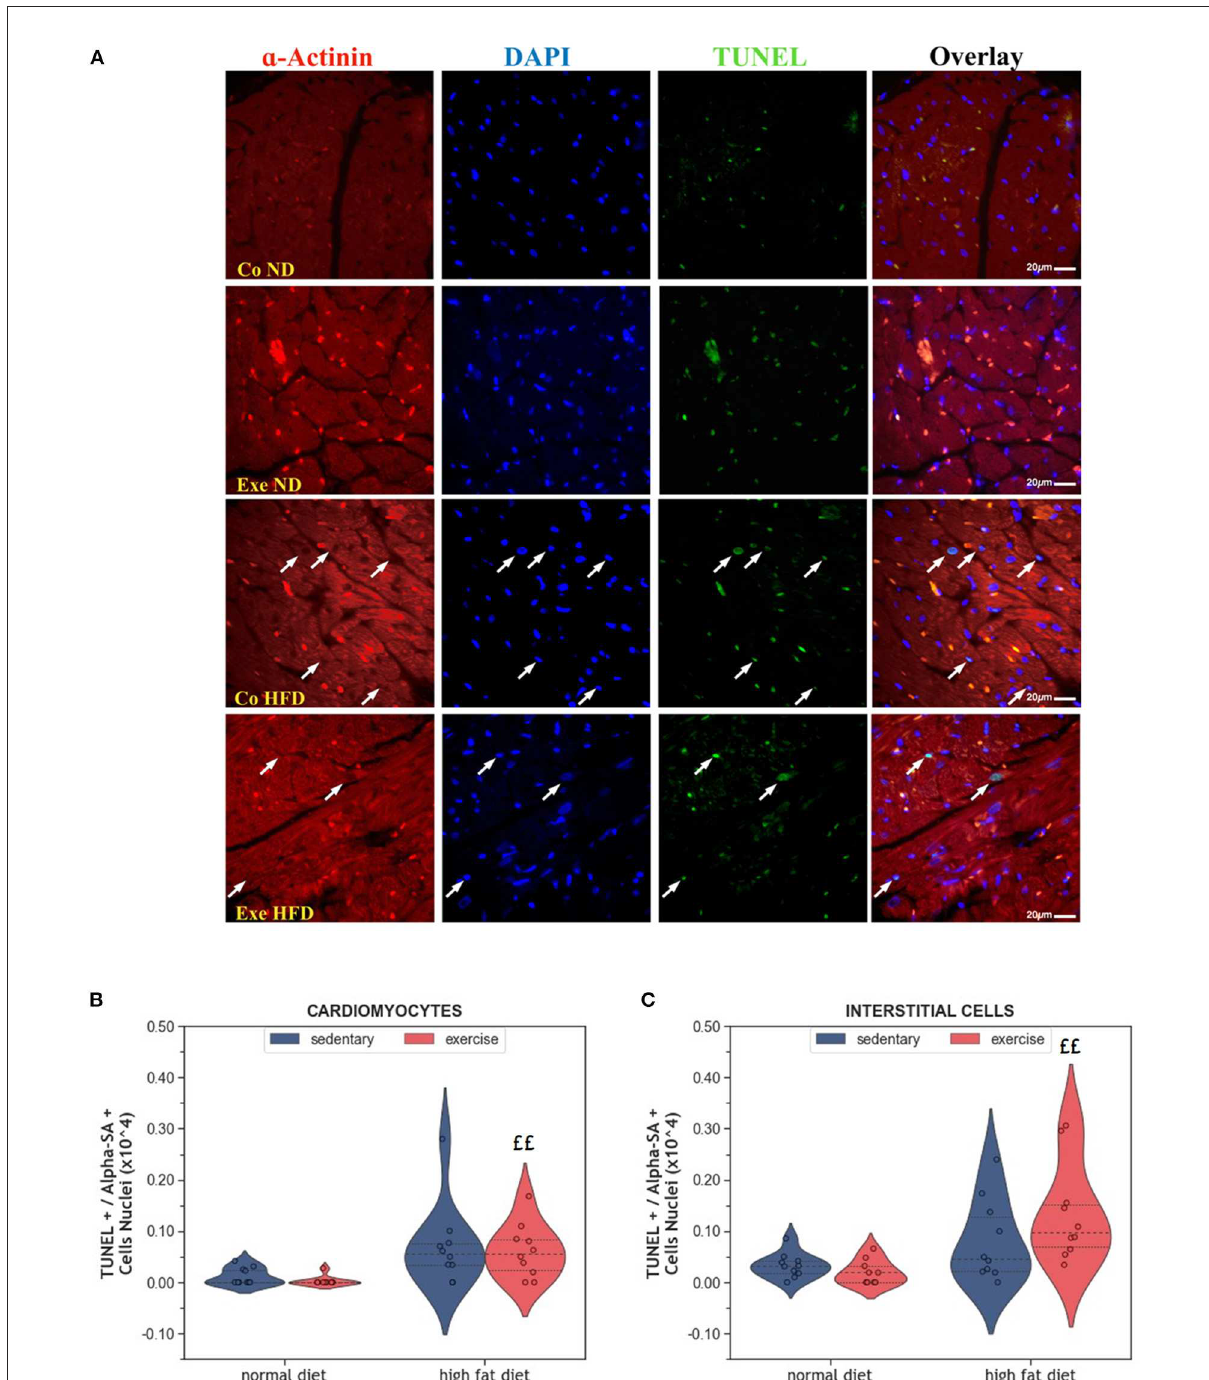
FIGURE3 (A) Representative histological images of left ventricular sections showing an increased number of apoptotic cardiomyocytes in HFD groups. The sections have been stained with a commercial kit for terminal deoxynucleotidyl transferase dUTP nick end labeling (TUNEL) assay. Arrows point to apoptotic nuclei. (B) Violin plot showing the left ventricular fraction of Sarcomeric alpha-actinin positive cardiomyocytes that are also TUNEL positive. (C) Violin plot showing the left ventricular fraction of Sarcomeric alpha-actinin negative TUNEL positive interstitial cells. From each experimental group 10 animals were selected for histomorphometry analysis. Statistical differences between groups were calculated with the Kruskal-Wallis test adjusted by the Bonferroni correction for multiple tests. p -values are only shown for pre-specified group comparisons. ££ p < 0.01 compared to the exercise normal diet